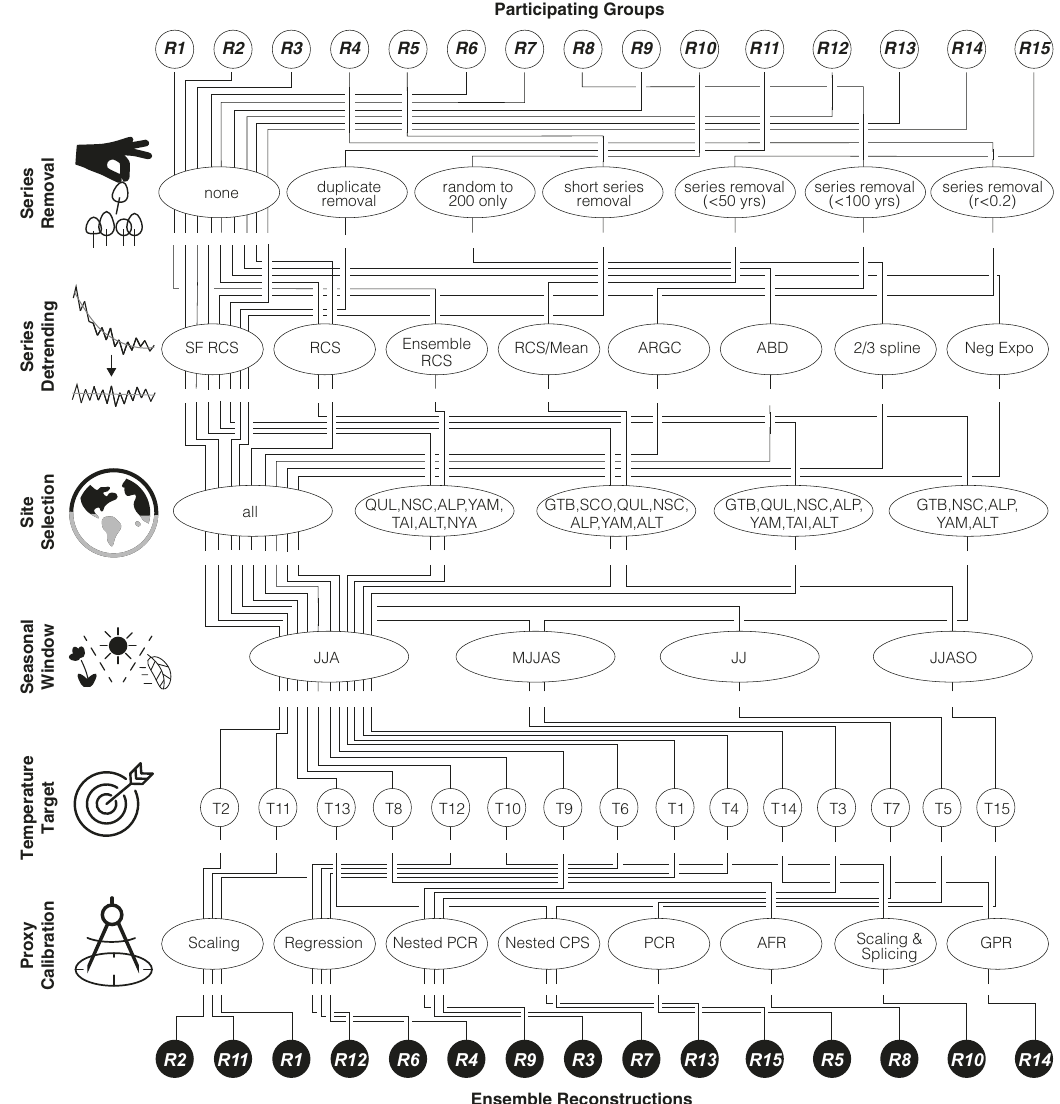
Fig. 2 Ensemble approach. Flow chart of the 15 large-scale Northern Hemisphere (NH) summer temperature reconstructions for the Common Era. SF RCS signal-free regional curve standardisation, ARGC adaptive regional growth curve, ABD age band decomposition for detrending, PCR principal component regressions, CPS composite plus scaling, AFR analogue frequency regression, and GPR gaussian process regression (see the “ Methods ” section and Supplementary Table 1 for details and further